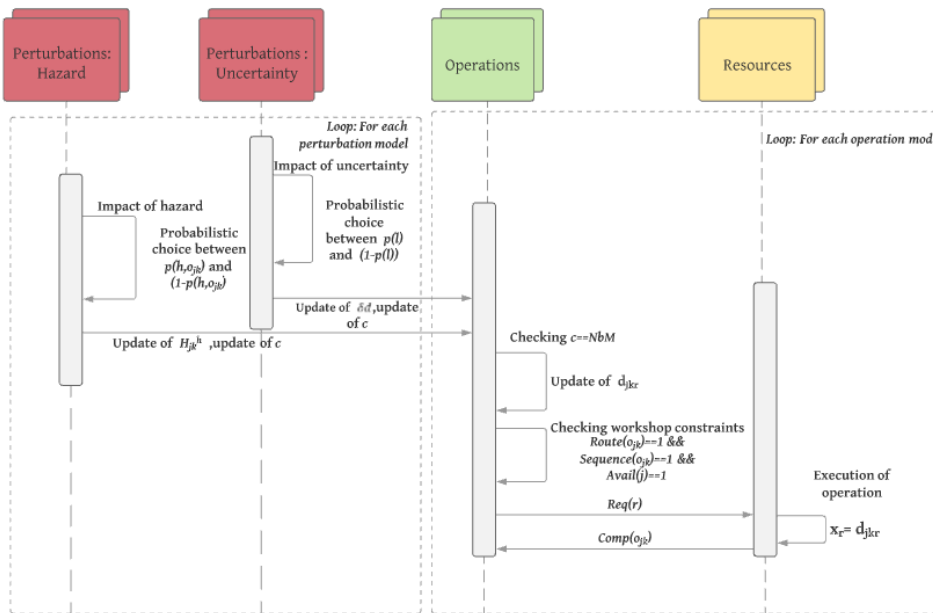
Figure 7. Evolution of modelling